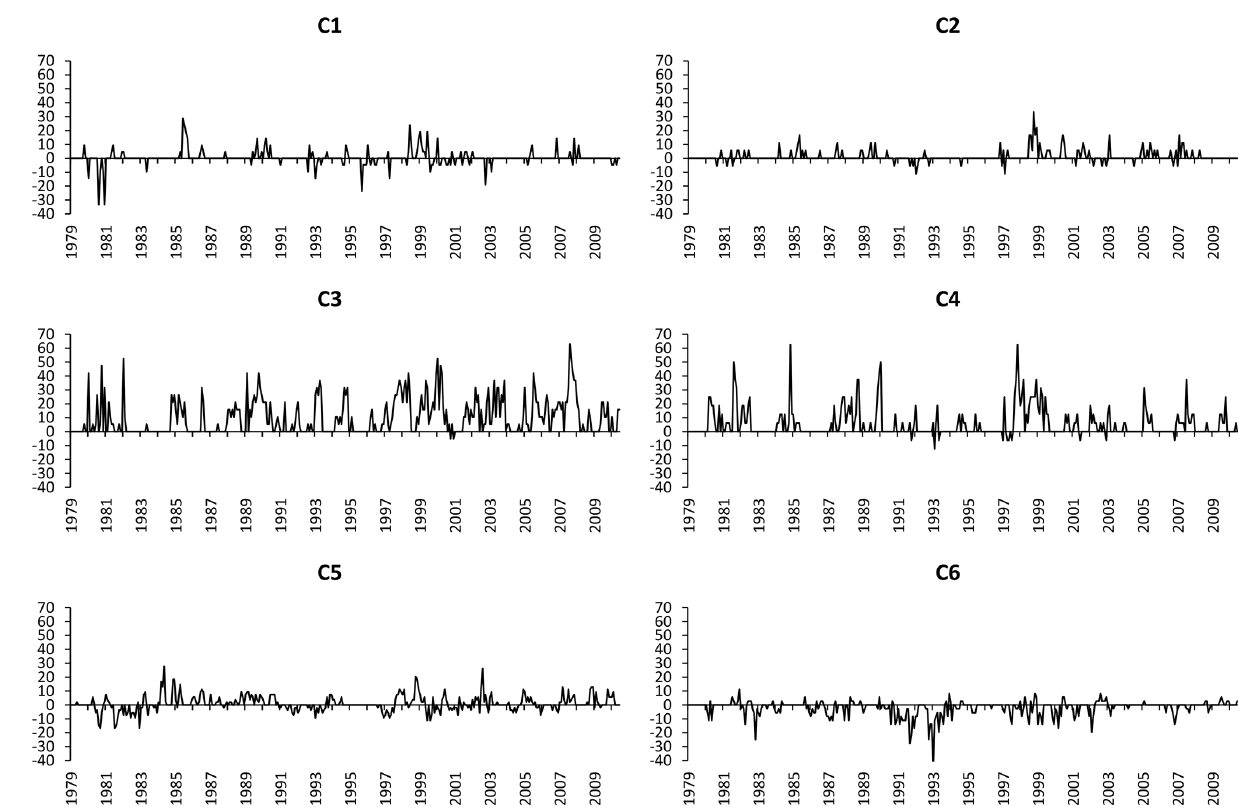
Figure 6. Difference in drought extent for SPEI cluster spatial groupings (Fig. 4b) between SPEI and SPI